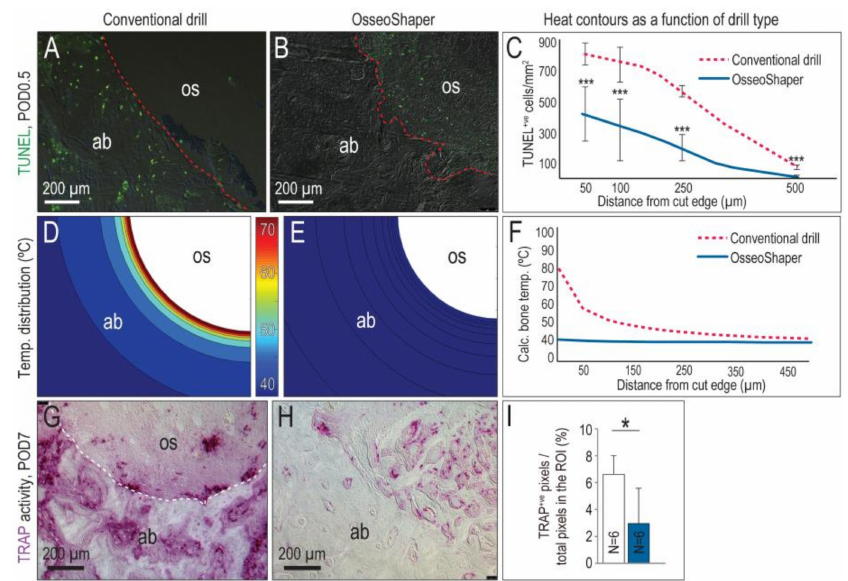
Figure 3. The OsseoShaper generates less heat, which results in a smaller zone of cell death and less tartrate-resistant acid phosphatase (TRAP)-mediated bone remodeling than conventional drills. ( A ) Representative tissue section from an osteotomy prepared using standard drills, where terminal deoxynucleotidyl transferase deoxyuridine triphosphate (dUTP) nick end labeling (TUNEL) +ve cells are apoptotic osteocytes. ( B ) Equivalent tissue section from an osteotomy prepared using the OsseoShaper, where the majority of apoptotic cells are detected in the osseous coagulum. ( C ) Distribution of TUNEL +ve cells as a function of distance from cut edge of osteotomy. Computational models were used to map the distribution of heat in bone as a function of distance from the cut edge, in osteotomies produced using ( D ) conventional drills and ( E ) using the OsseoShaper. ( F ) Calculated temperatures in bone, expressed as a function of radial distance from conventional drills (dotted red line) and from the OsseoShaper (blue line) ( N = 6). ( G ) Representative transverse tissue section from an osteotomy produced with conventional drills, analyzed on for TRAP activity on post-osteotomy day 7 (POD7). ( H ) TRAP activity on a representative transverse tissue section from an OsseoShaper-produced osteotomy. ( I ) Quantification of TRAP +ve pixels/total pixels in the region of interest (ROI). A dotted line is used to indicate the cut edge of the osteotomy. Asterisk indicates p < 0.05. Scale bars = 200 µ m. Abbreviations: as indicated